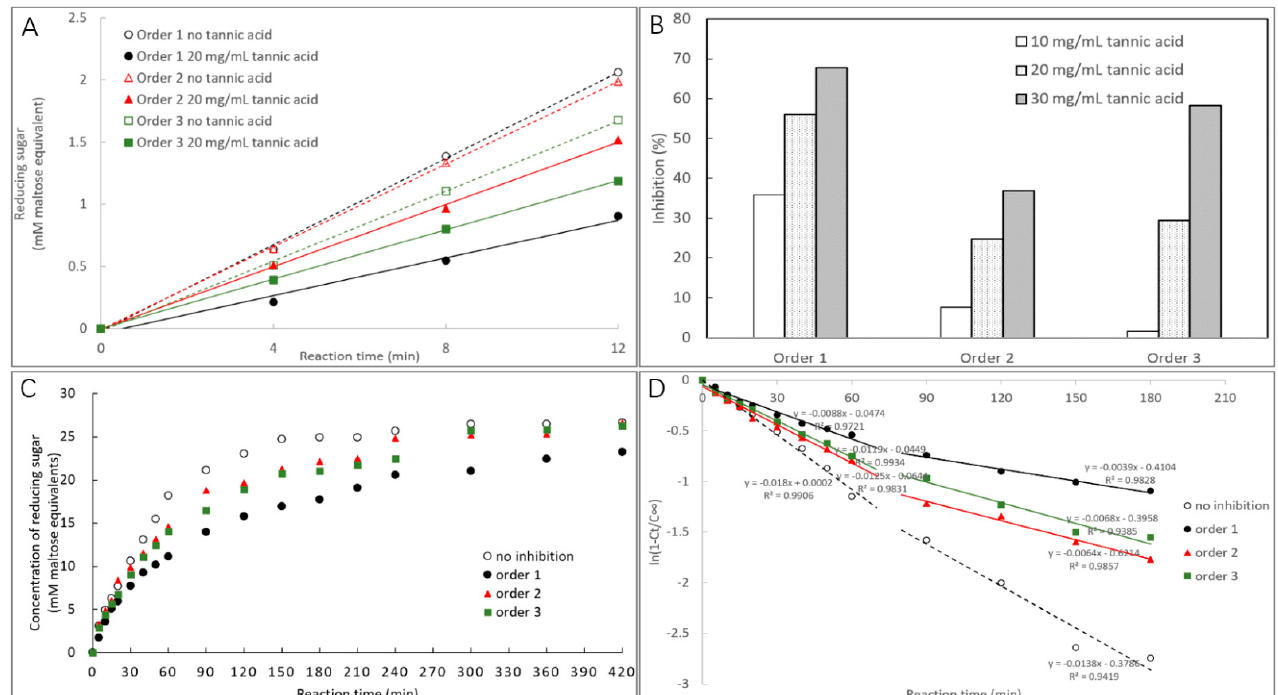
Figure 1. The contents of reducing sugars (maltose equivalents) produced along with starch digestion at a time interval of 4 min in the absence and presence of TA for three mixing procedures, and the initial reaction velocity was obtained from the slope of plot of reducing sugar contents against digestion time ( A ). Based on this, the enzyme inhibition of TA for three mixing procedures at the low (10 mg/mL) and high (20 and 30 mg/mL) TA concentrations were obtained ( B ). The time course of starch digestion in the absence and presence of TA for three mixing procedures ( C ). The logarithm of slope (LOS) analysis for the fraction of digested starch along with digestion time ( D ), from which the digestion rate constants k in each digestion phases were obtained.